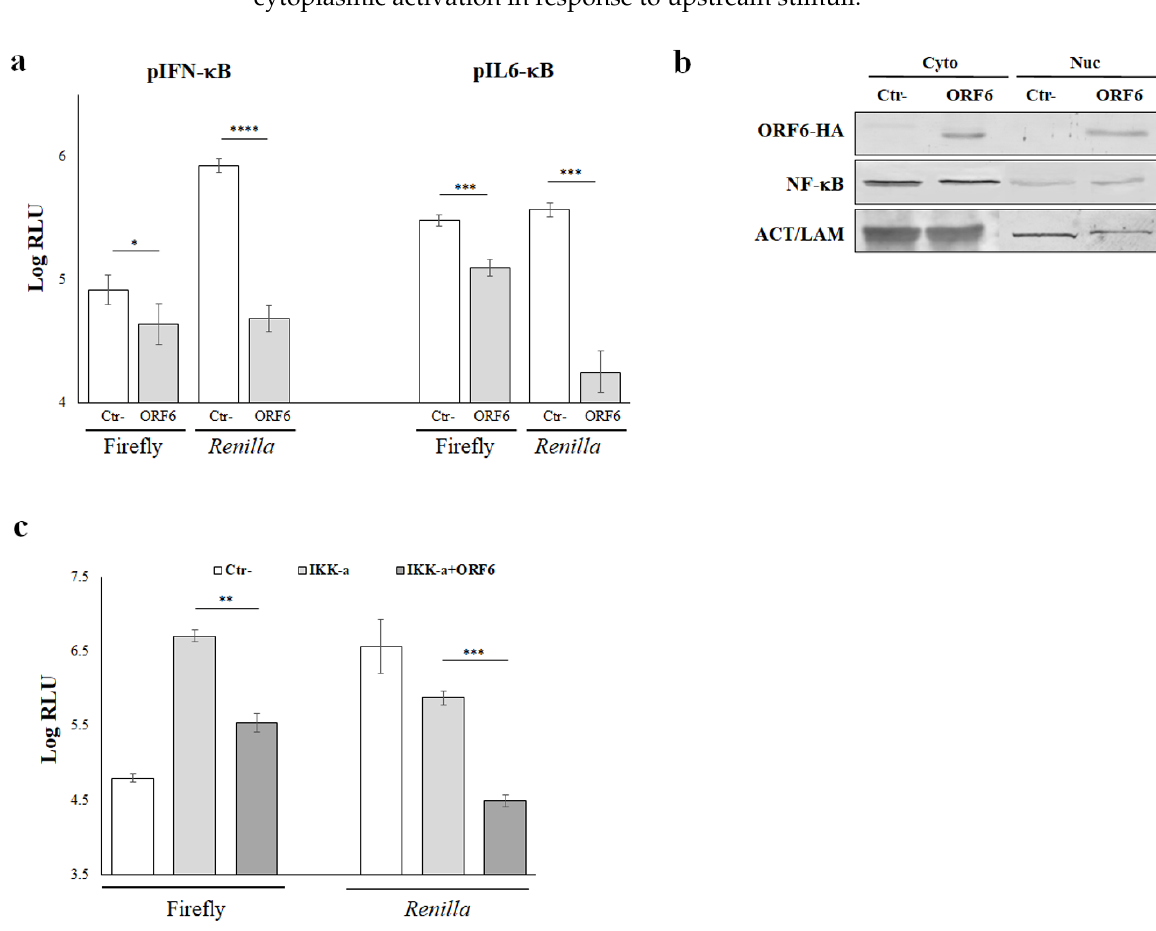
Figure 3. NF- κ B activity is affected by ORF6 protein. ( a ) Interleukin-6 or -IFN- β minimal promoters Figure 3. NF-κB activity is affected by ORF6 protein. ( a ) Interleukin-6 or -IFN-β minimal promoters containing the NF-kB responsive elements only (pIL6- κ B and pIFN β - κ B, respectively) were used containing the NF-kB responsive elements only (pIL6-κB and pIFNβ-κB, respectively) were used to to drive firefly luciferase expression in HEK-293T cells. Renilla luciferase reporter plasmid was co-transfected as an internal control. Three ( n = 3) independent measurements were performed and representative data are presented as mean logarithm values of relative luminescence unit (RLU) ± standard deviations. Significance was evaluated as p < 0.05 (**** p < 0.00001, *** p < 0.0005, ** p < 0.005, * p < 0.05, n.s. = not significant). ( b ) NF- κ B nuclear translocation was evaluated in